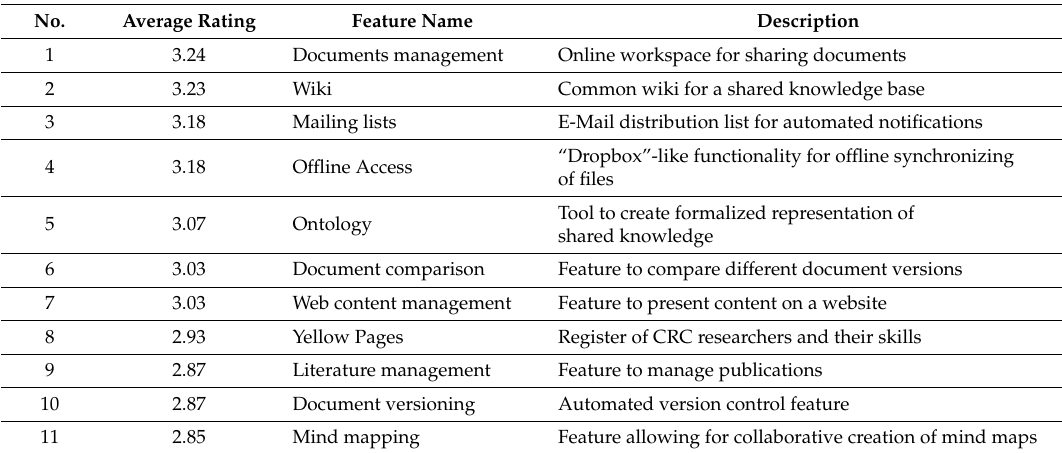
Figure 2. Potential interfaces between individual projects of the CRC 102. Table 1. Functional features identified by INF and ranked according to user feedback.